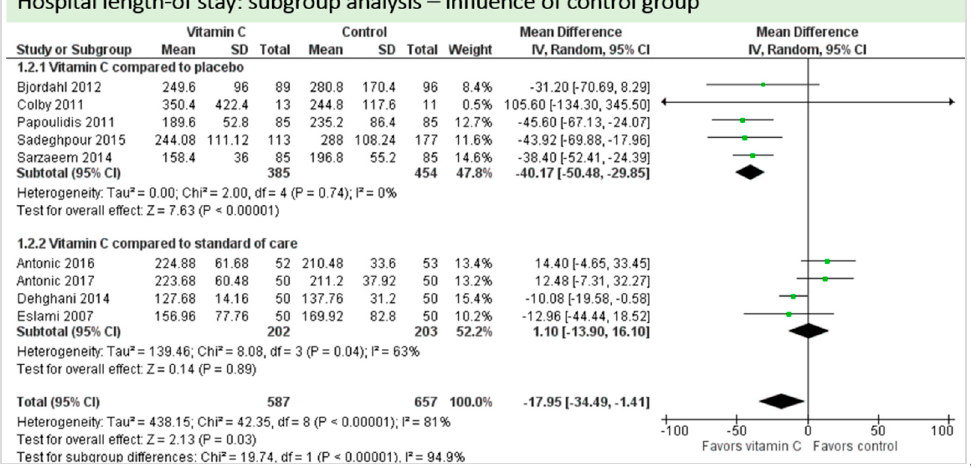
Figure 21. Hospital length of stay: subgroup analysis—influence of control group.